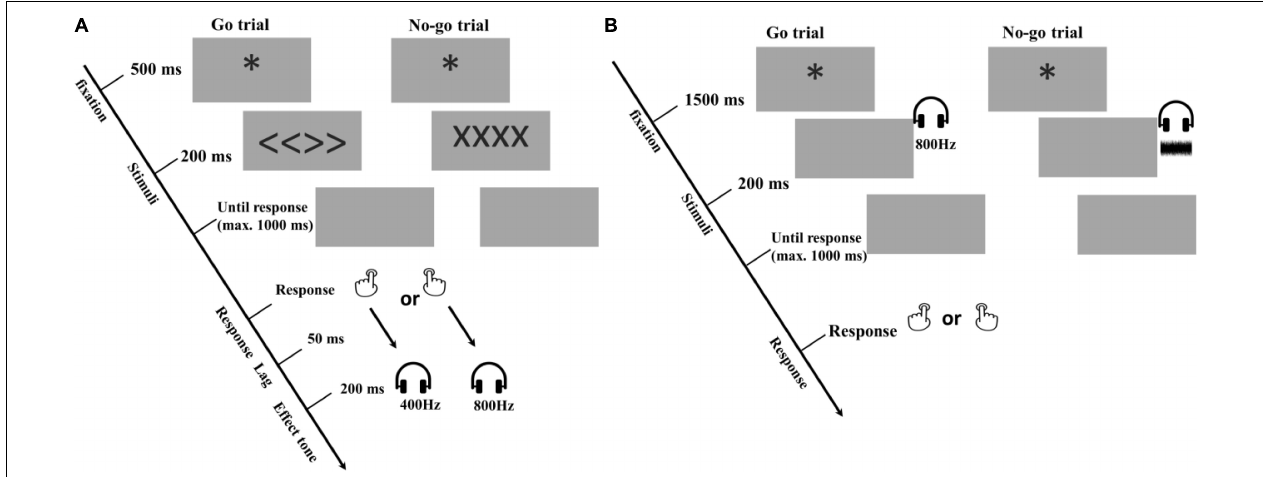
FIGURE 1 | Procedure of Experiment 1. (A) acquisition phase for all the experiments. (B) free choice ideomotor test phase of Experiment 1. In the present example of the acquisition phase, the left response is always followed by a low tone (i.e., 400 Hz); whereas the right response is always followed by a high tone (i.e., 800 Hz), but these mappings were